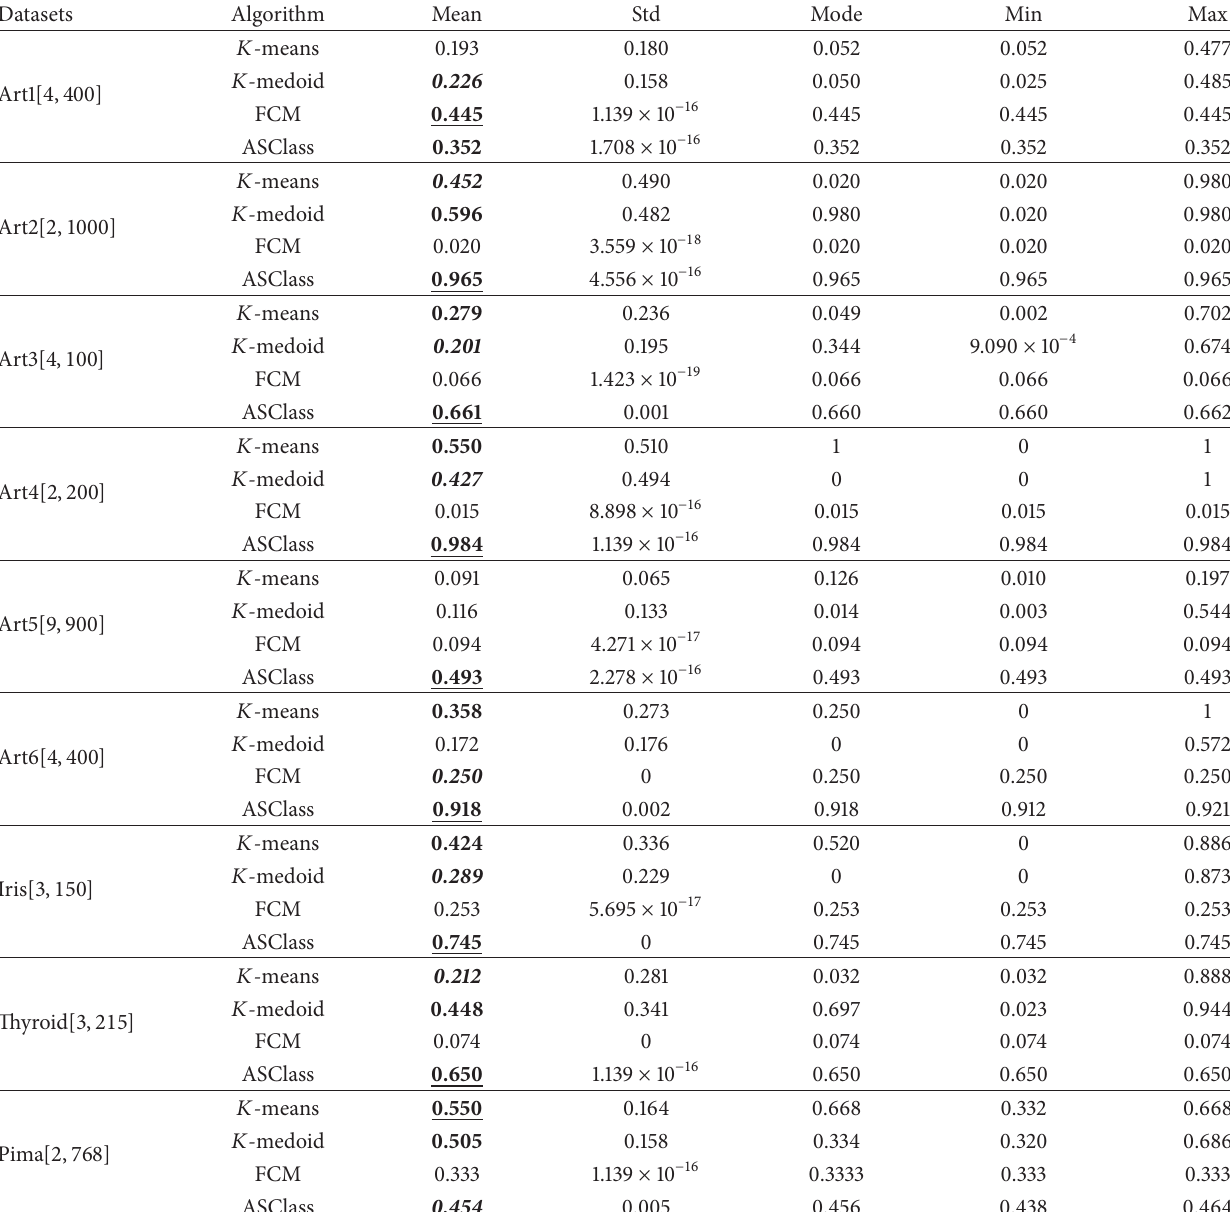
Table 5: Mean, standard deviation, mode, min, and max values of accuracy classification achieved by each clustering algorithm ( 𝐾 -means, 𝐾 -medoid, FCM, and ASClass) over 20 trials on dataset presented in Table